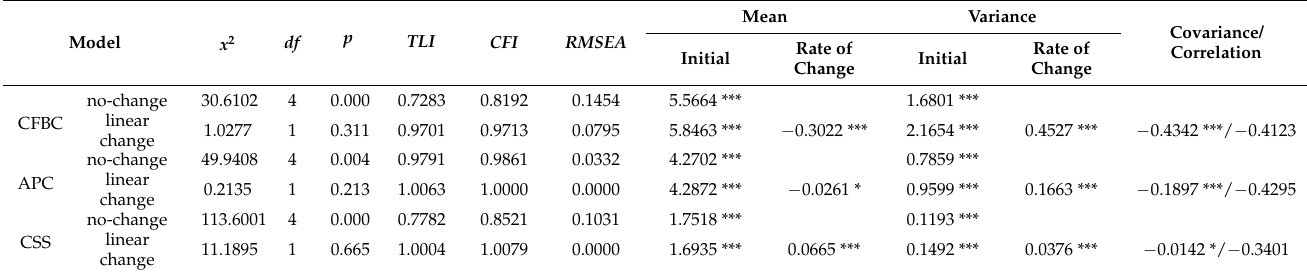
Table 4. Model fitness for each variable and the results of the